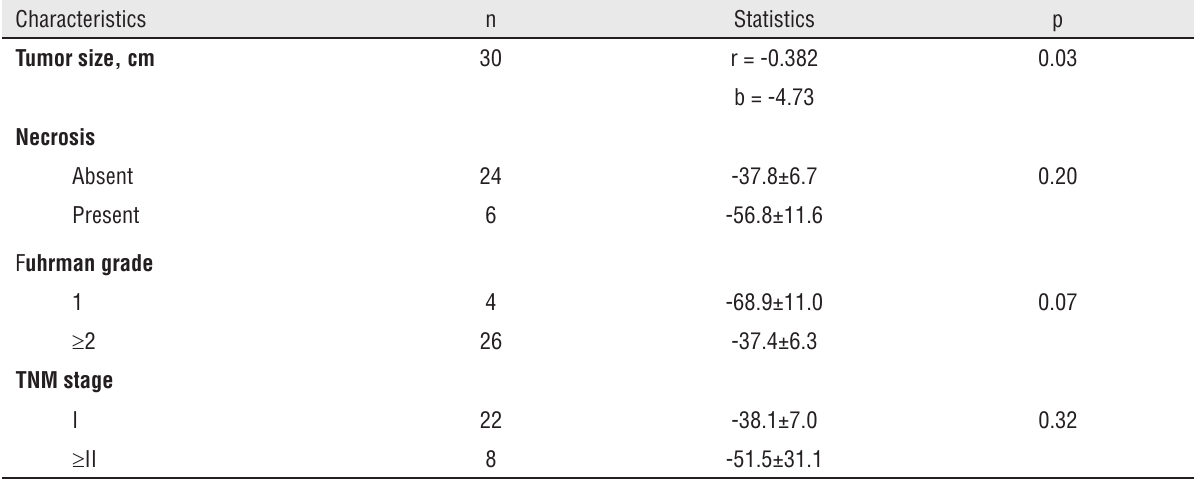
Table 2 - Association between the decrease in serum TF levels and selected prognostic factors. Characteristics n Statistics